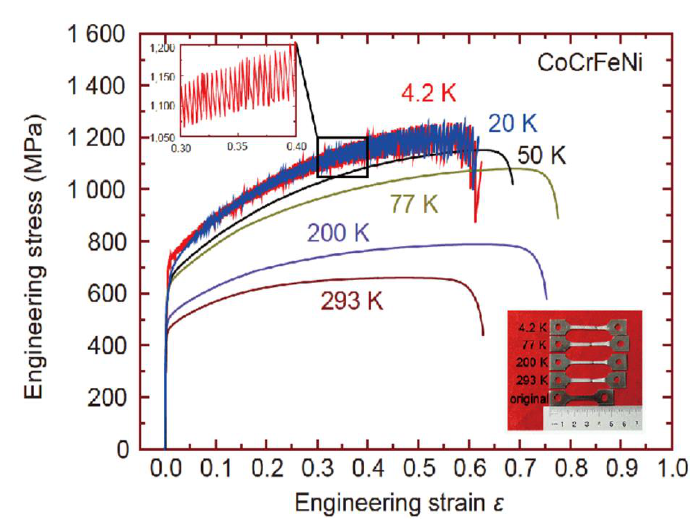
Figure 46. The engineering stress vs. engineering strain curves for the CoCrFeNi HEA tested at temperatures ranging from 4.2 to 293 K and a strain rate of 10 − 3 s − 1 . The inset displays a magnification of the serrated flow behavior from the specimen tested at 4.2 K. The inset at the bottom-right portion of the figure displays a photograph of the dog-bone-shaped samples, before and after tensile tests. (Reproduced from [159] with permission.)